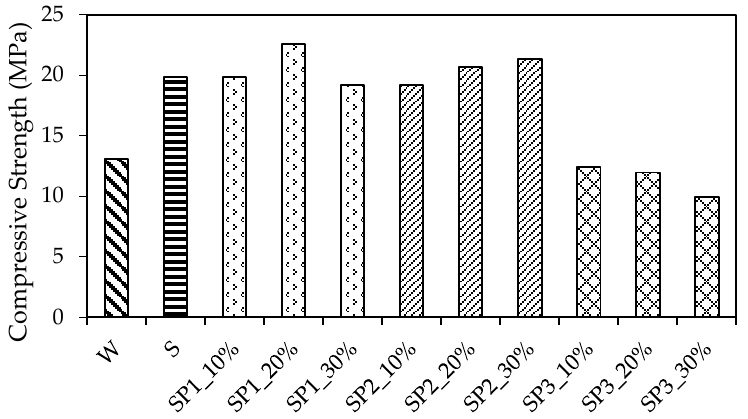
Figure 7. Comparison of compressive test results.